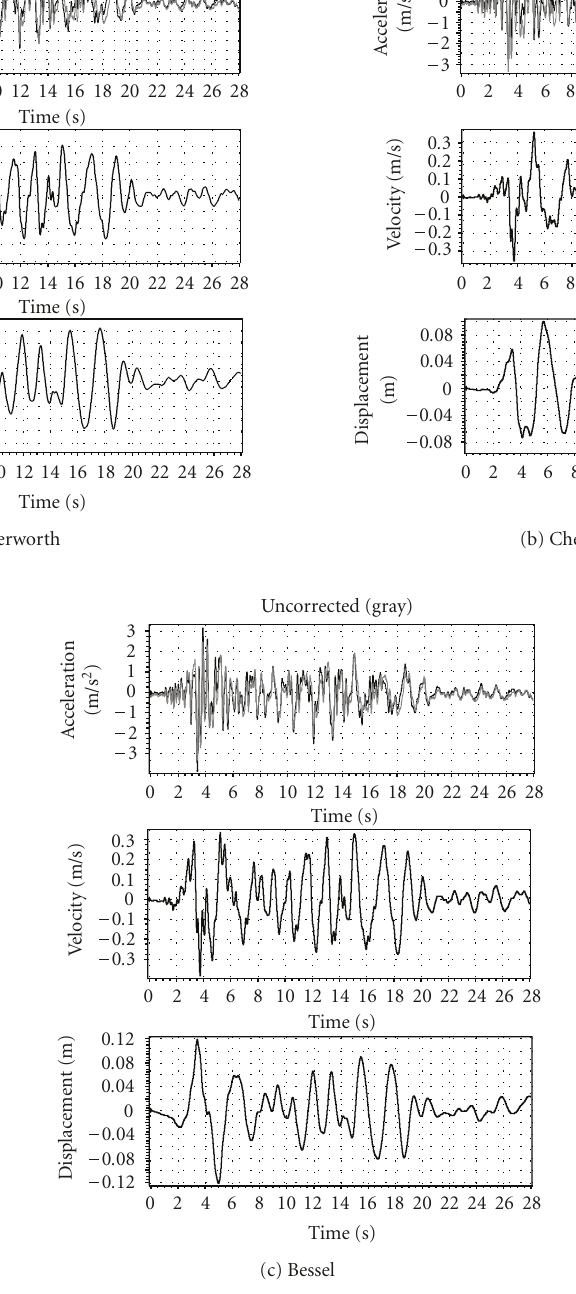
(vi) significant duration TD: the interval of time over which a proportion (percentage) of the total I a is accu- mulated (by default: the interval between the 5% and 95%